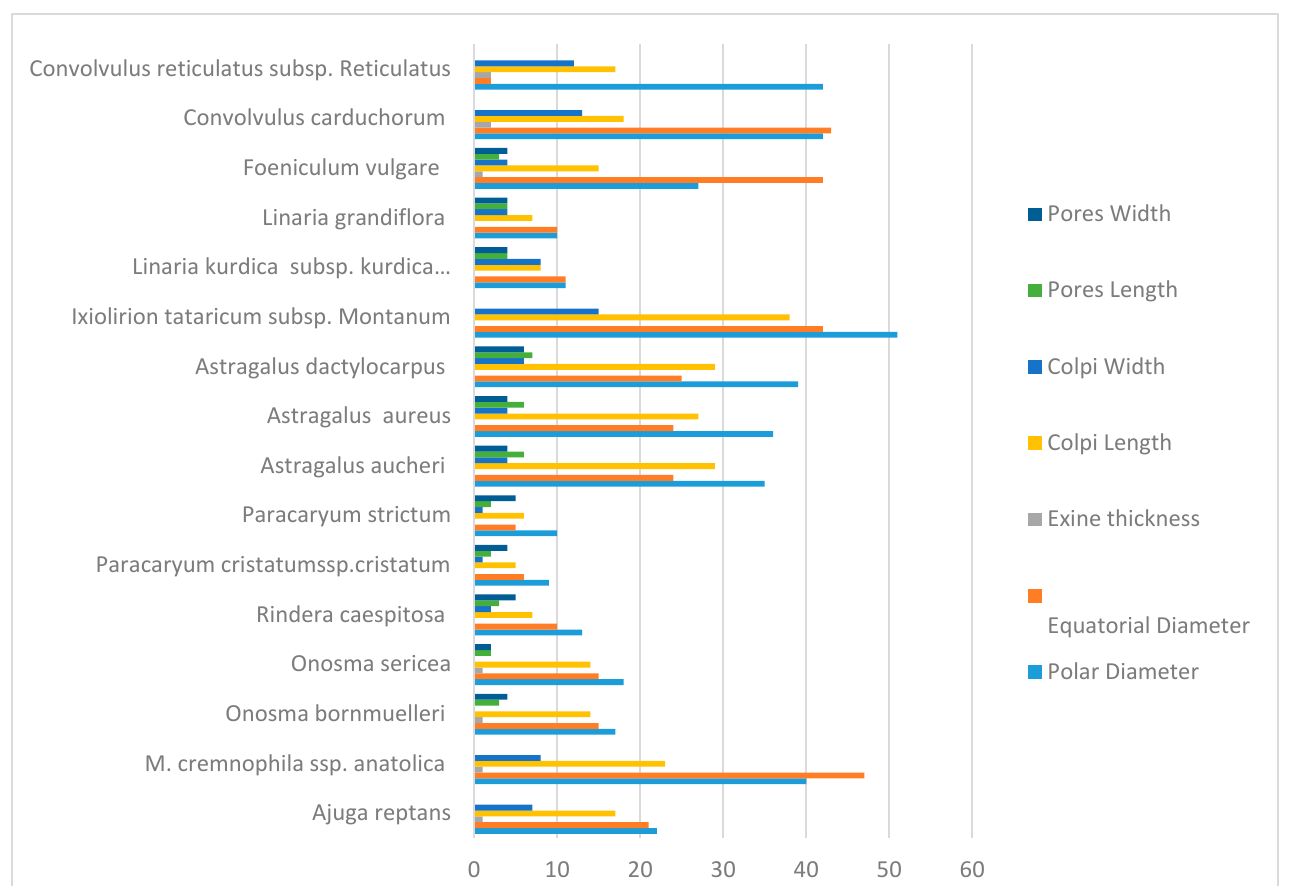
Figure 2. Graph of pollen’s morphological measurements of the studied taxa.